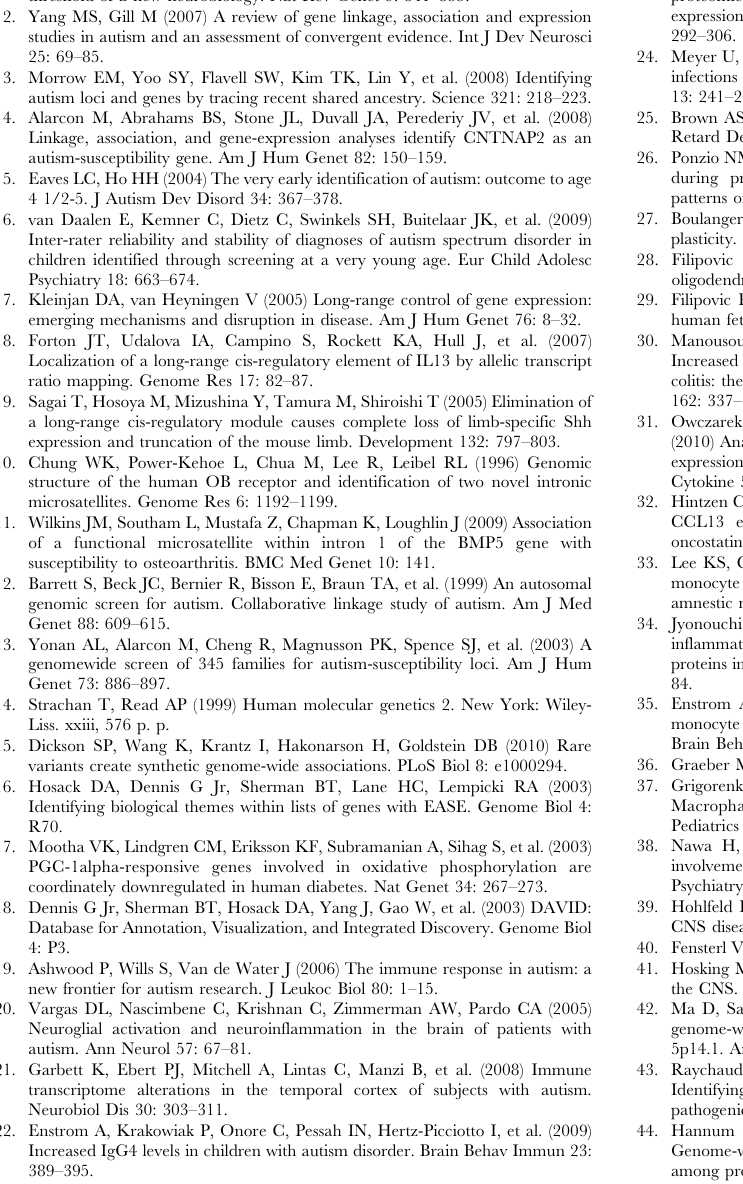
Table S7 LoGS without LOD: Except for two gene sets in the lower part of the top 20 ranking all the other gene sets are consistent across the LoGS which use the LOD score and the LoGS without the use of the LOD score. V= enrichment score. Table S8 LoGS data